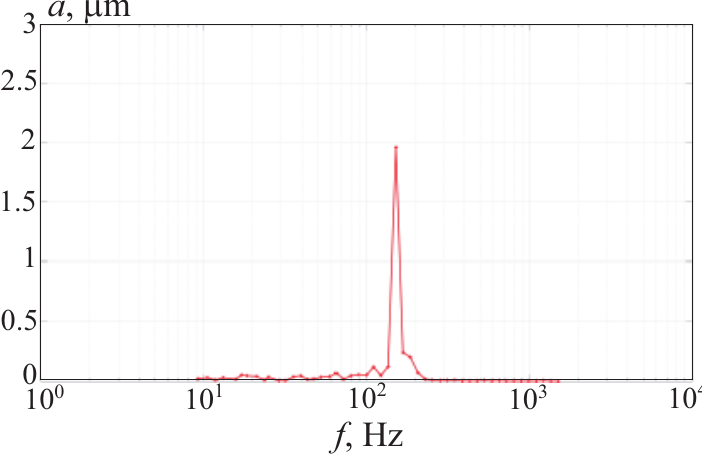
Figure 14. The dependence of the displacement amplitude on the frequency at the point ( 0.5,0,0 )